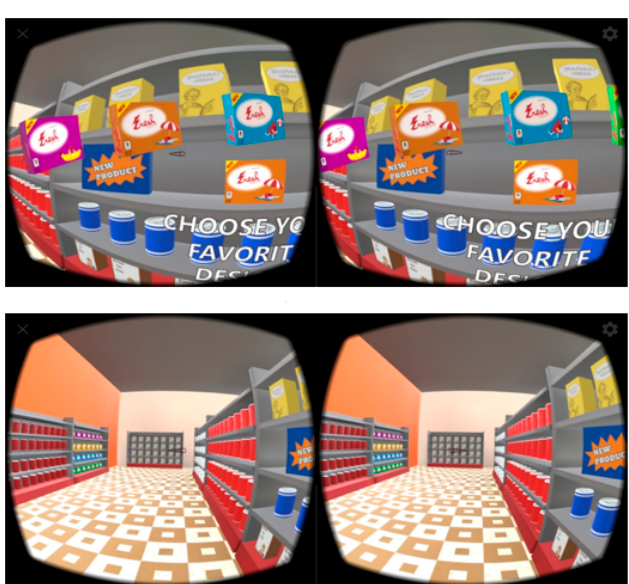
Figure 3. Prototype´s interface: The images at the top show how the label design selection looks like, also the images at the bottom show the supermarket